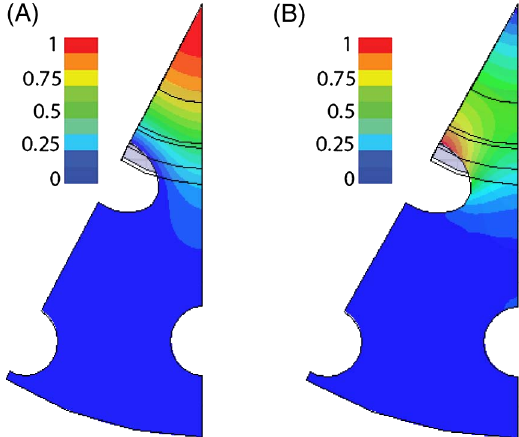
FIG. 7. Electric (a) and magnetic (b) field amplitudes looking at a top-down view of the structure. The peak surface electric field of 207 MV = m for a 100 MV = m accelerating gradient is seen on axis. The peak surface magnetic field of 713 kA = m for an accelerating gradient of 100 MV = m is confined to the center of the inner surface of the innermost rod.